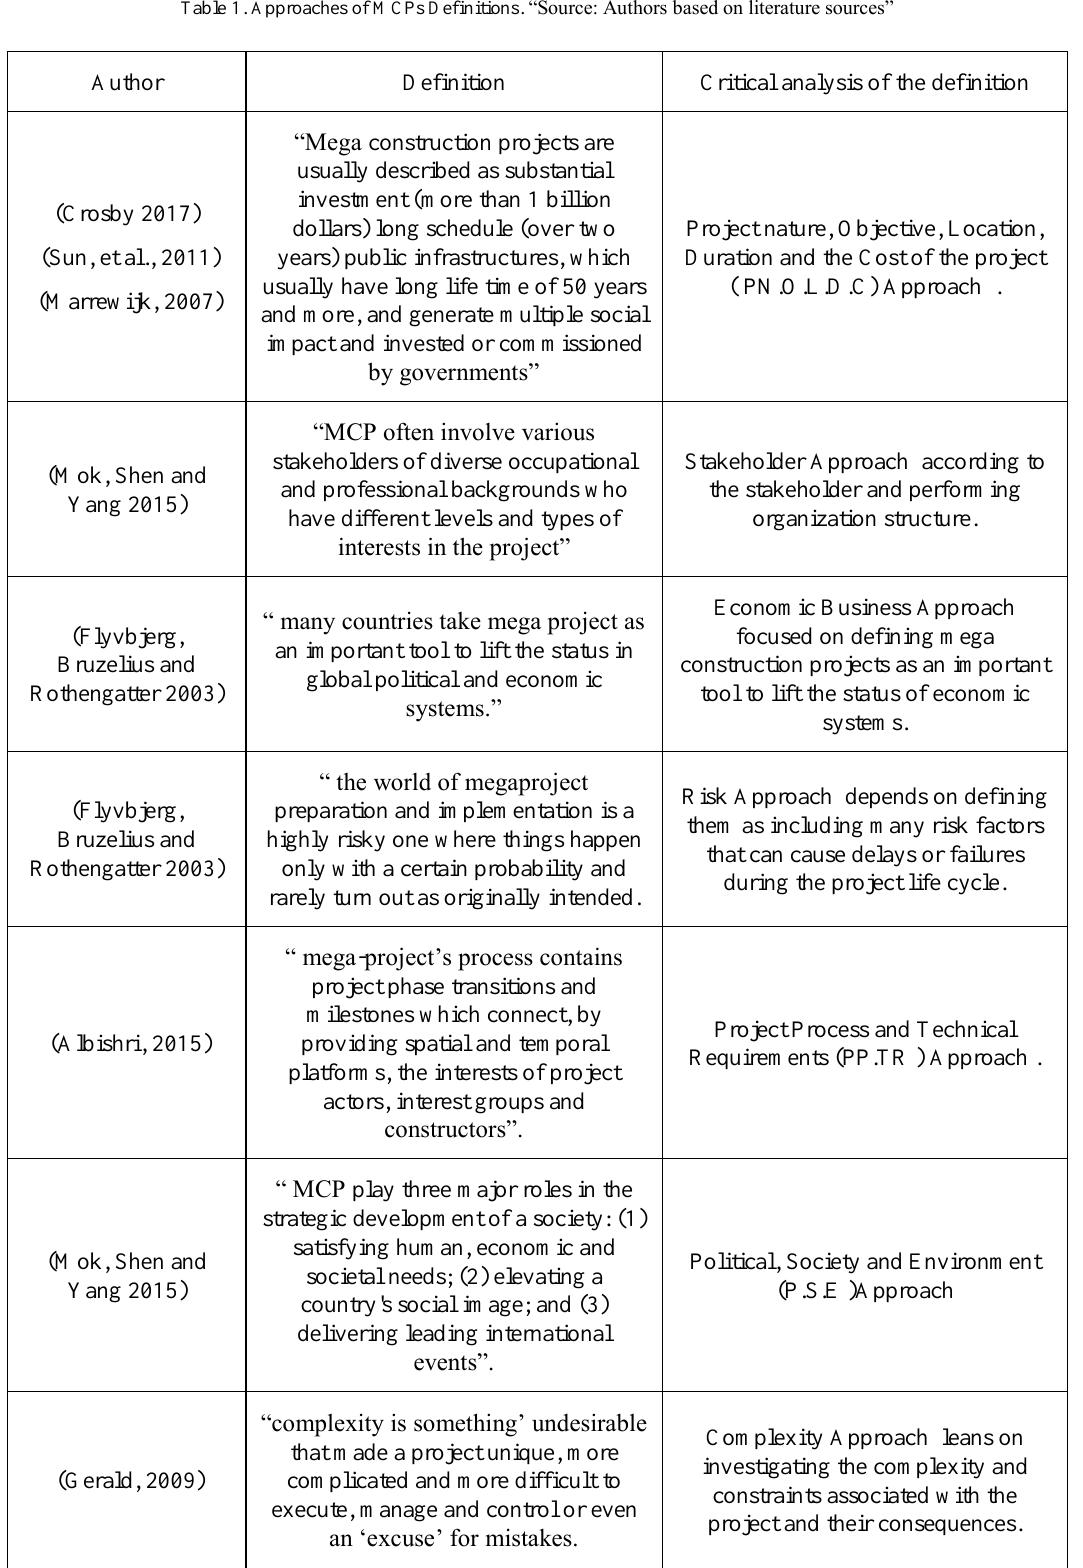
Table 1. Approaches of MCPs Definitions. “Source: Authors based on literature